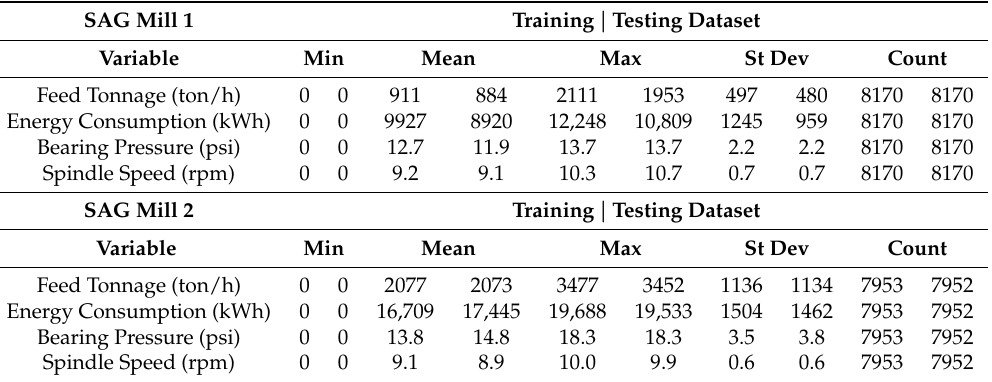
Table 2. Summary statistics over training testing dataset on semi-autogenous grinding mill (SAG)